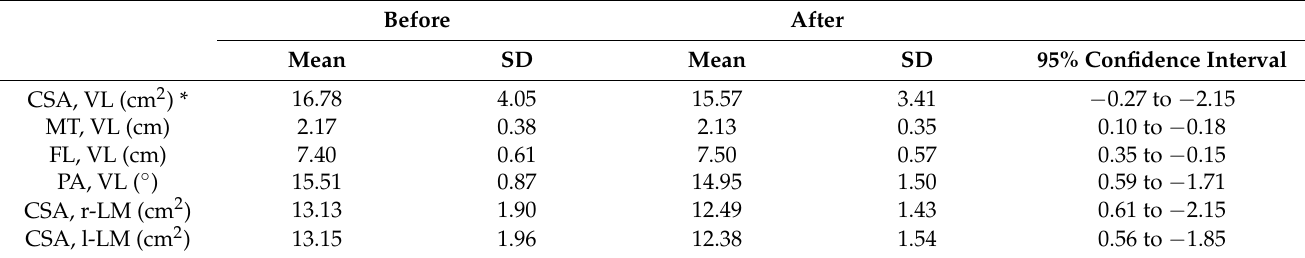
Table 5. Measured muscle ultrasound parameters at baseline and after the altitude expedition on